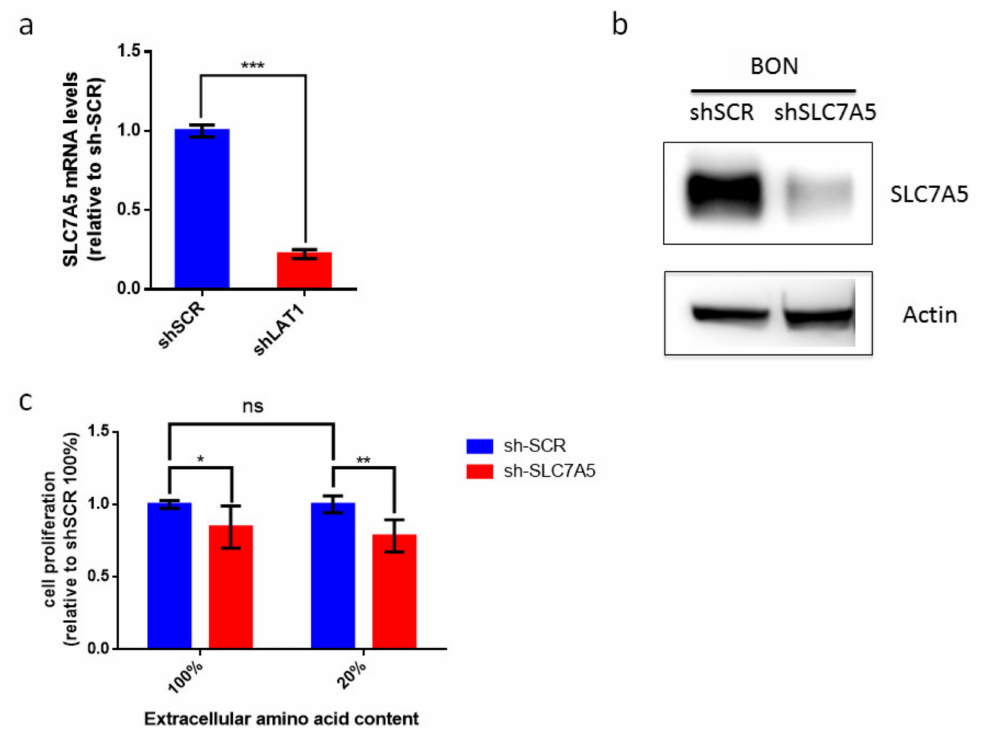
Figure 5. Contribution of LAT-1 (SLC7A5) to cell proliferation of BON tumor cell line. ( a ) Relative LAT-1 (SLC7A5) mRNA levels in sh-SCR and sh-SLC7A5 BON cells. Data are represented as the mean and error bars represent SEM ( n = 3, *** p < 0.001). ( b ) Western blot analysis of SLC7A5 and actin protein levels in sh-SCR and sh-SLC7A5 BON cells. ( c ) BON sh-SCR and sh-SLC7A5 were cultured for 72 h in normal media (100%) or media containing 20% amino acid content. BON cell proliferation does not di ff er significantly between 100% and 20% amino acid content media. Proliferation of sh-SLC7A5 BON cells is expressed relative to sh-SCR BON cells in both amino acid content conditions. Data a represented as the mean and error bars represent SEM ( n = 6) * p < 0.05, ** p <